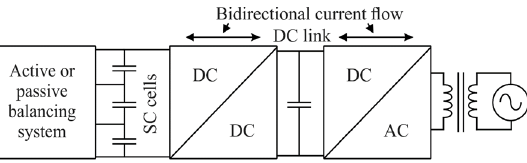
Figure 1. Traditional SC-based ESS block diagram; arrows indicate bidirectional current flow.